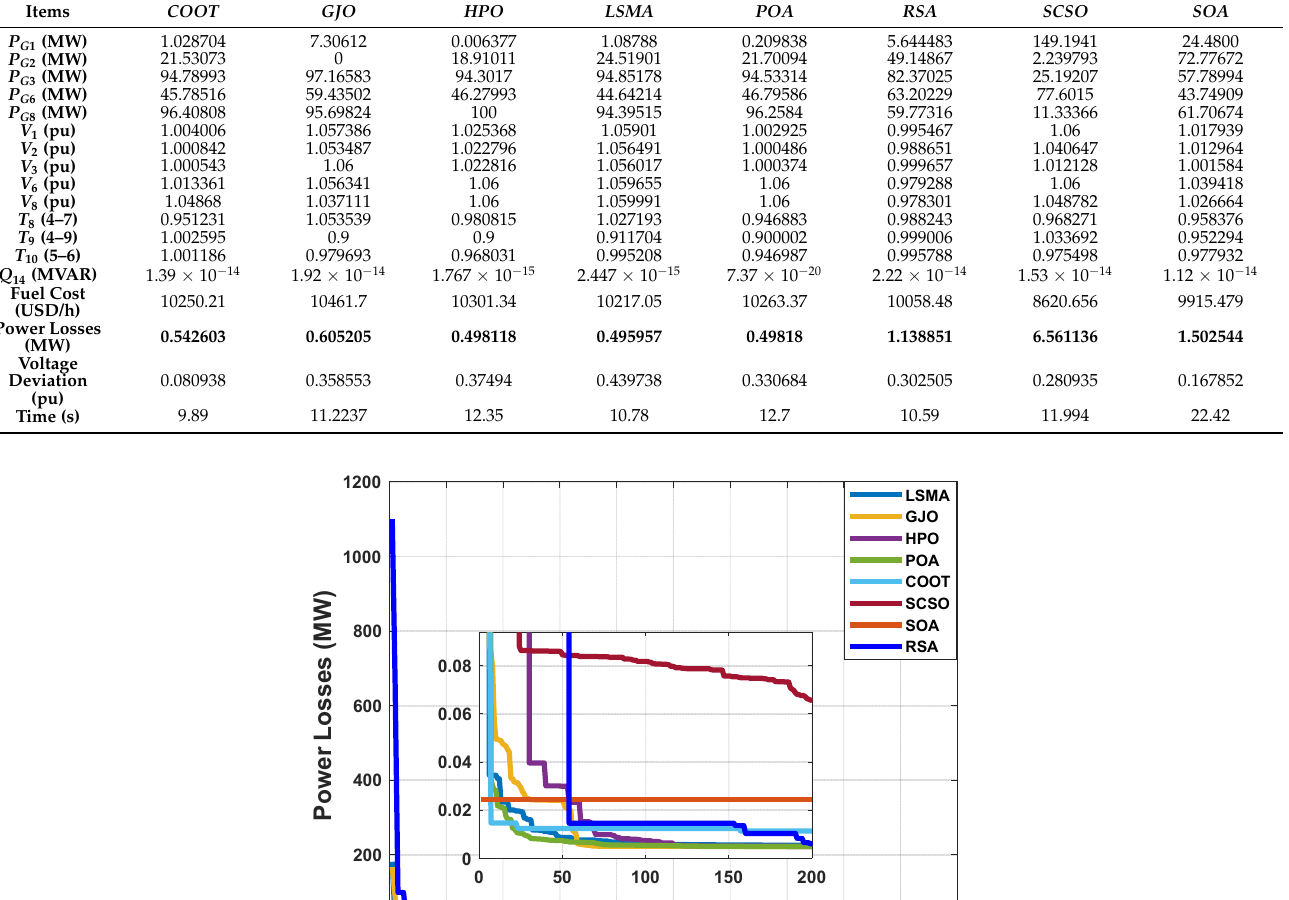
Table 3. Optimal control variables for the IEEE-14 bus test system for minimizing real power loss.